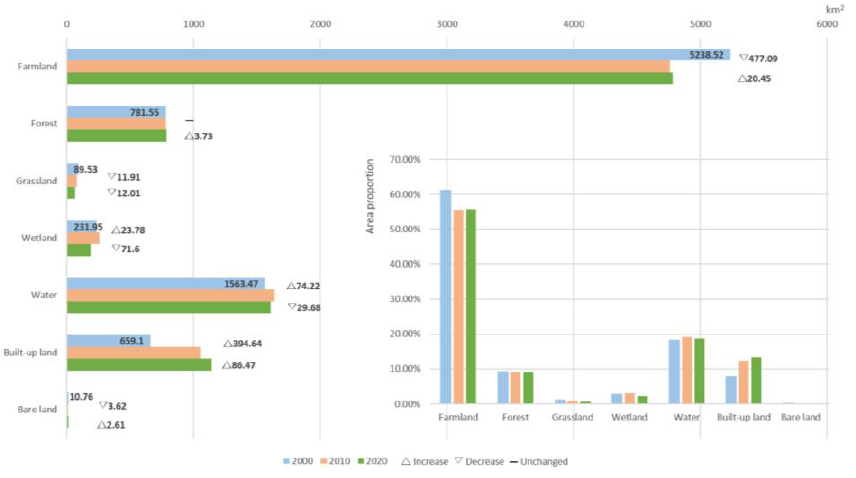
Figure 3. Changes of land use area of Wuhan.